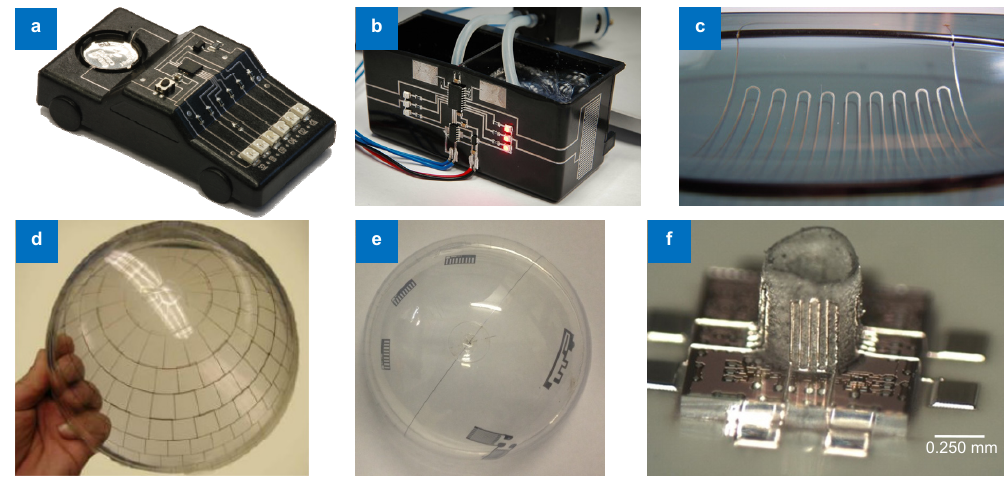
Fig. 11 | 3D printed electronics using Aerosol Jet printing from Optomec 28-30 . (a ) 3D MID demonstrator. ( b ) 3D MID with integrated sensor. ( c ) Printed conformal electronics (curve). ( d ) Printed conformal electronics (dome). ( e ) Printed conformal electronics (dome). ( f ) Sub-mm length scale, custom made 3D